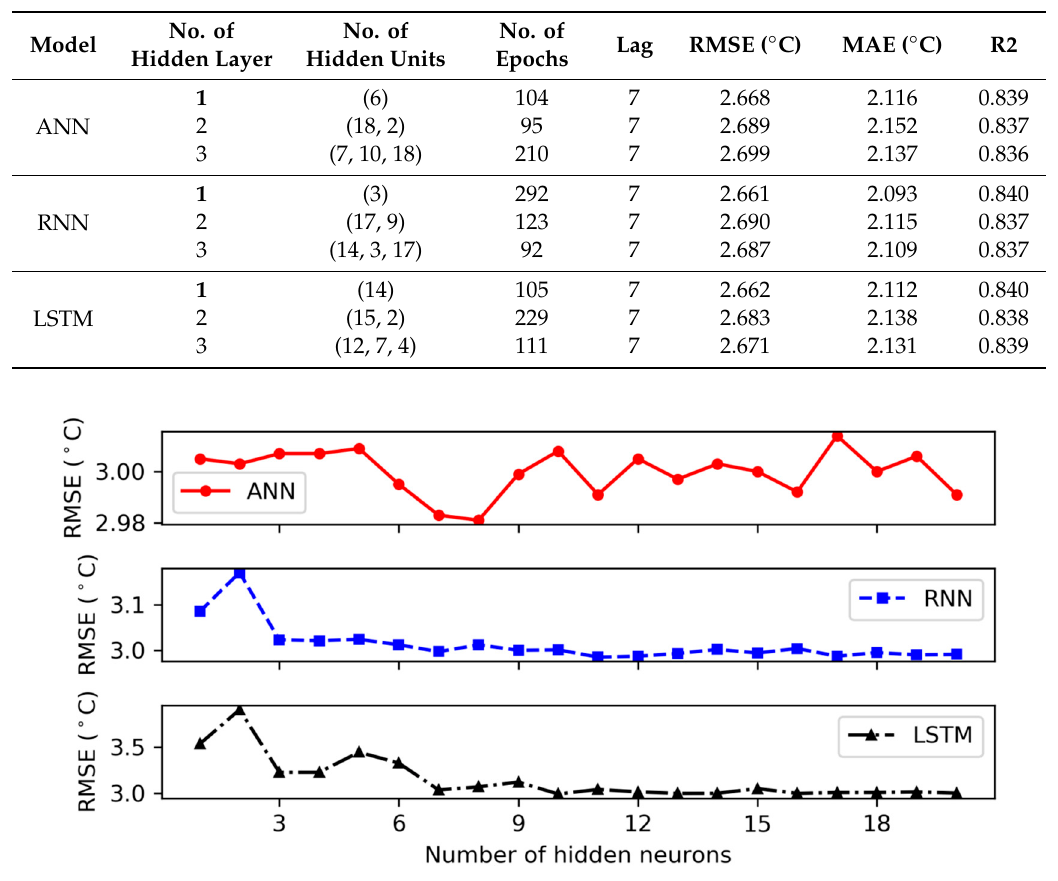
Table 5. The performance measure of models for autumn.